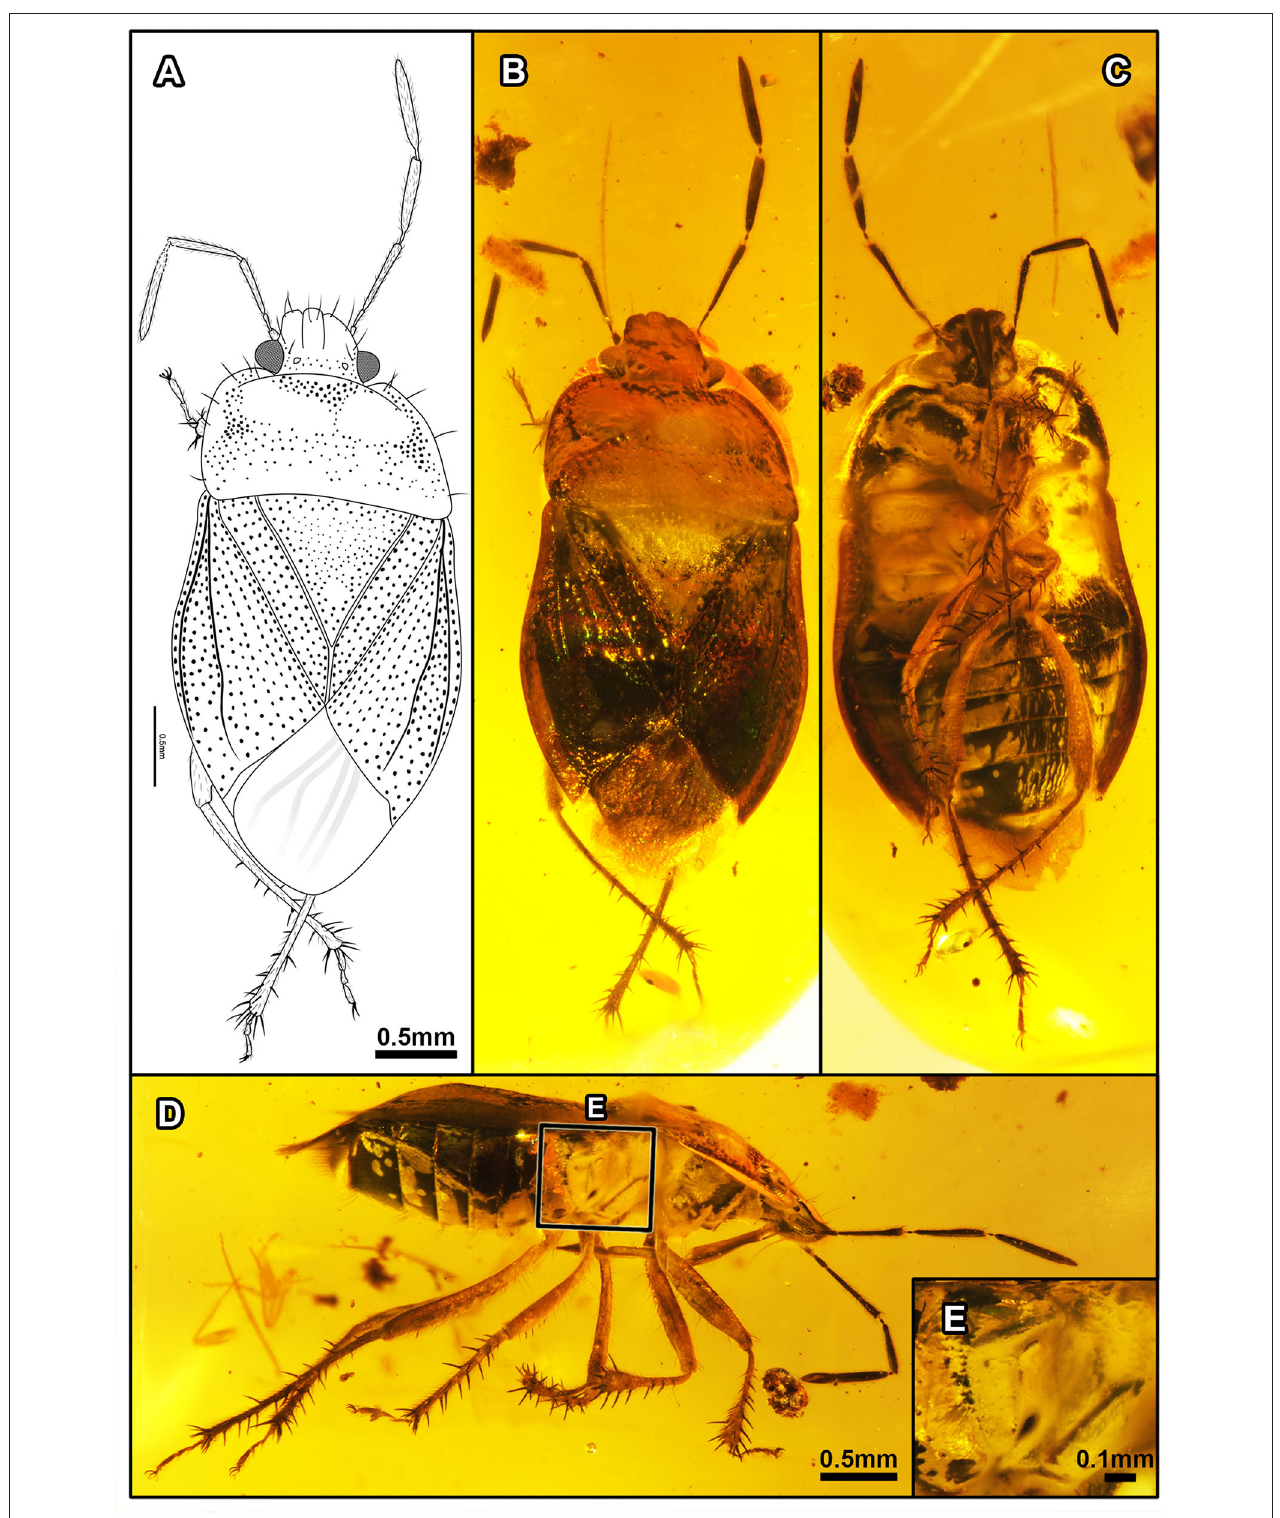
FIGURE 5 | Laevigemma lisorum gen. et sp. nov., in Burmese amber. Related to Figure 2 . Holotype, CNU-HET-MA2019004 (male). (A) Line drawing in dorsal view. (B) Habitus in dorsal view. (C) Habitus in ventral view. (D) Habitus in right lateral view. (E) Detail of metathoracic scent gland, as located on (D) . Scale bars: A = B = C = 0.5mm; D = 0.5mm; E = 0.1mm.